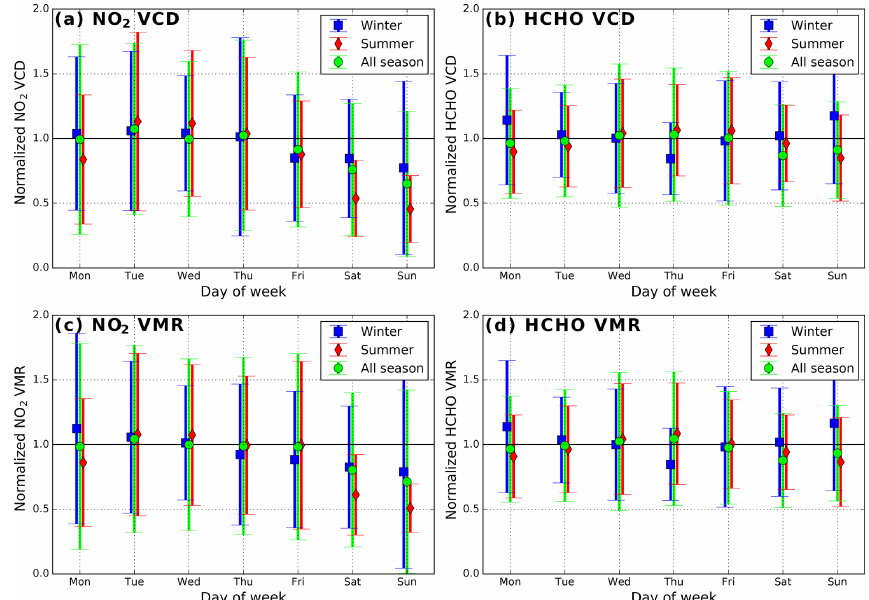
Figure 5. Panels (a) and (c) show the averaged weekly cycle of NO 2 (a) VCD and (c) volume mixing ratio at the surface layer. Panels (b) and (d) are the same as panels (a) and (c) but for HCHO. Measurements are separated for winter (December, January and February, blue markers), summer (June, July and August, red markers) and all seasons (green markers). The data are normalized by dividing by the mean weekday value (Monday to Friday). Error bars indicate the 1 σ standard deviation variation range.